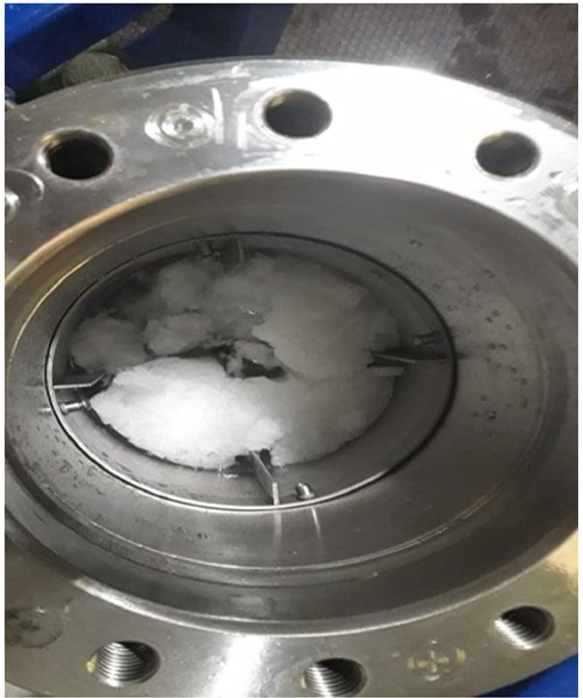
Figure 1. Methane hydrate formed with single impeller and surface